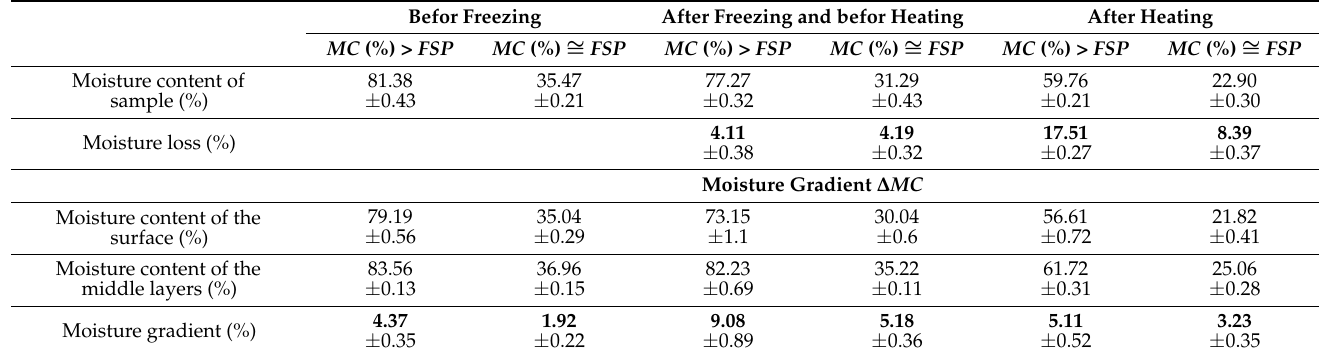
Table 1. Moisture content of the samples, moisture loss, and values of the moisture gradient.